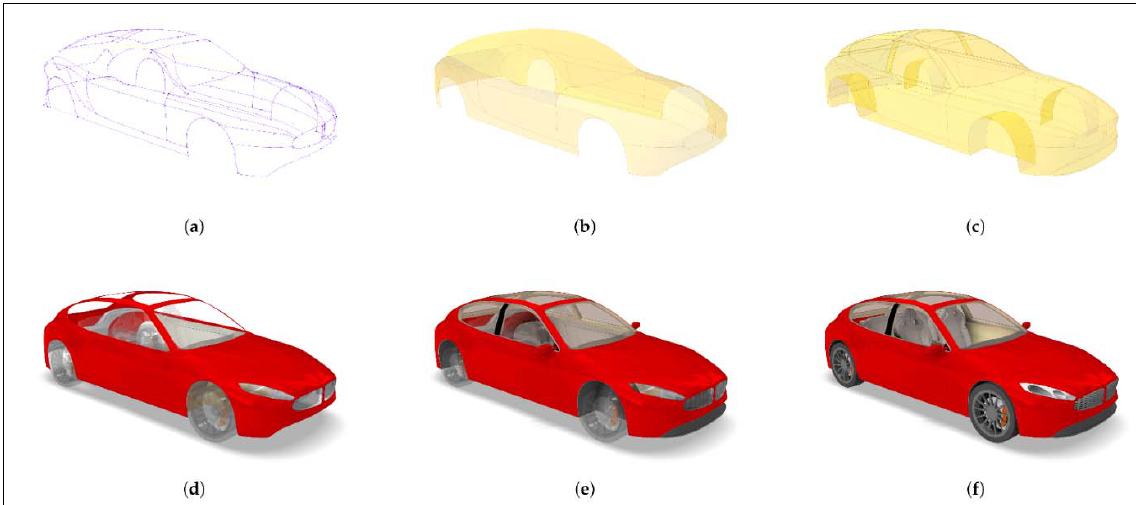
Figure 16. Stages of surface modelling for the Retrò version: ( a ) 3D sketching according to 2D drawings; ( b ) preliminary surface modelling; ( c ) watertight surface; ( d ) surface thickening and integration with chassis; ( e ) frame modelling; ( f ) final CAD model.